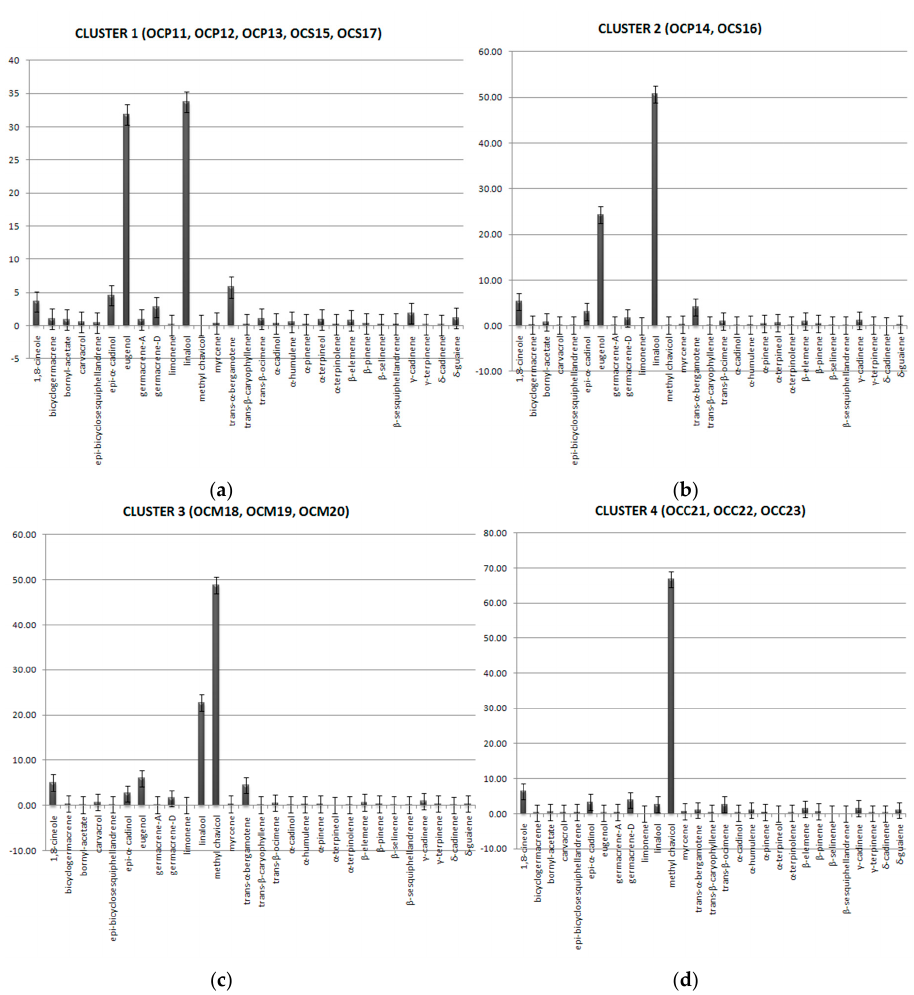
Figure 4. Clusters formatted according to the dominant compounds identified in varieties latifolia, minimum, lettuce and cinnamon, cultivated in the field conditions. ( a ) Dominant compounds in var. latifolia (1st, 2nd and 3rd harvest) and var. minimum (1st and 3rd harvest); ( b ) Dominant compounds in var. latifolia (4th harvest) and var. minimum (2nd harvest); ( c ) Dominant compounds in var. lettuce (1st , 2nd, and 3rd harvest); ( d ) Dominant compounds in var. cinnamon (1st, 2nd and 3rd